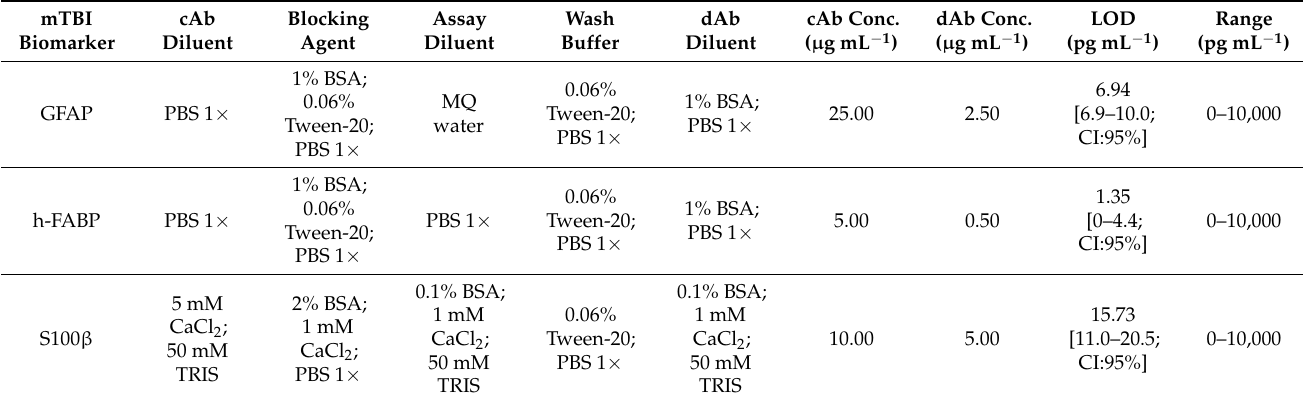
Table 2. Preliminary conditions evaluated on MSD platform for each individual mTBI biomarker ECL sandwich immunoassay ( singleplex